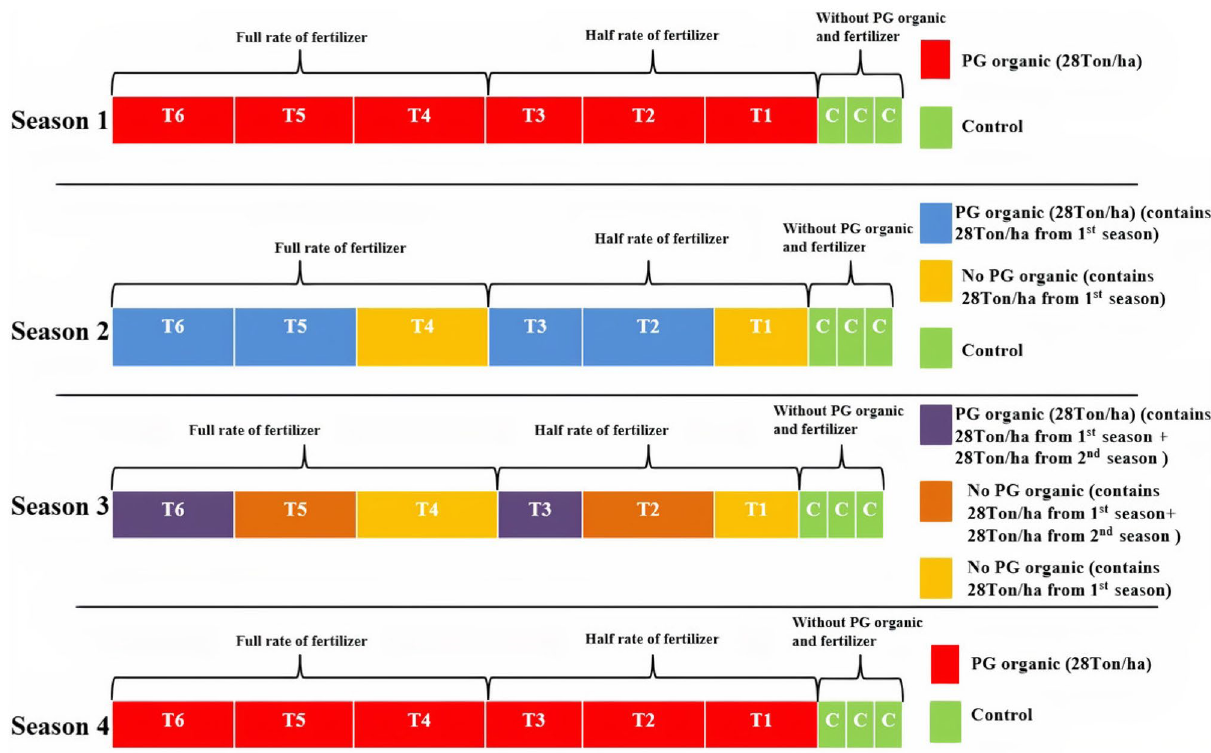
Figure 4. The sub-plots receiving the PG organic conditioner treatment for 3 cropping seasons for kenaf, maize, and guinea grass. Blue represents the sub-plot receiving the soil conditioner for each cropping season, and yellow represents the sub-plot receiving residual